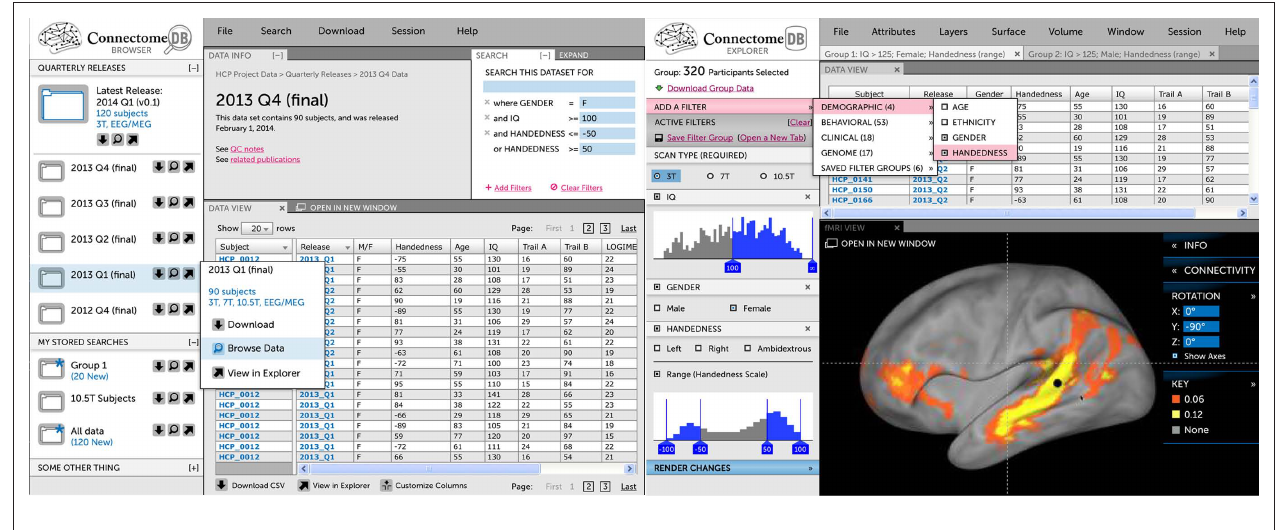
and Workbench view are fed by ConnectomeDB’s open API. (Right) This mockup of the Download track illustrates the track’s emphasis on guiding users quickly to standard download packages and navigation to